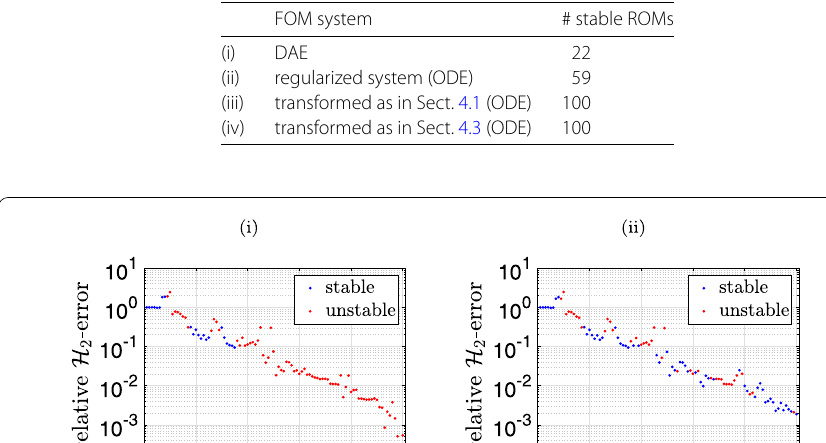
Table 6 Number of asymptotically stable systems out of 100 ROMs with dimensions 1, ... ,100 in MOR of stochastic Galerkin system for band-pass filter